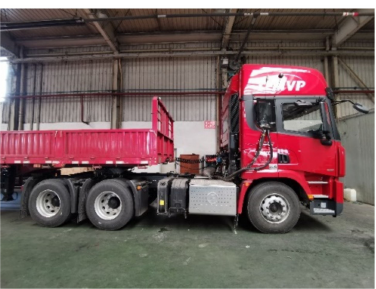
Figure 1. Semi-trailing tractor used in the study with a six-ton trailer